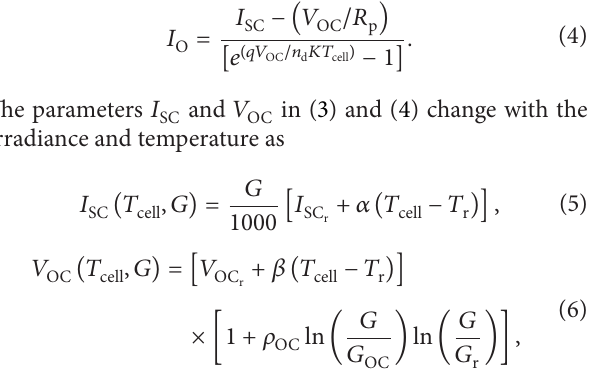
Figure 1: Single-diode model of a solar cell with series ( 𝑅 ) shunt ( 𝑅 p